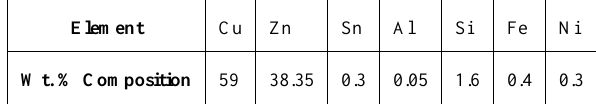
Table 2: Spectrometric compositional analysis of 60/40 Brass.